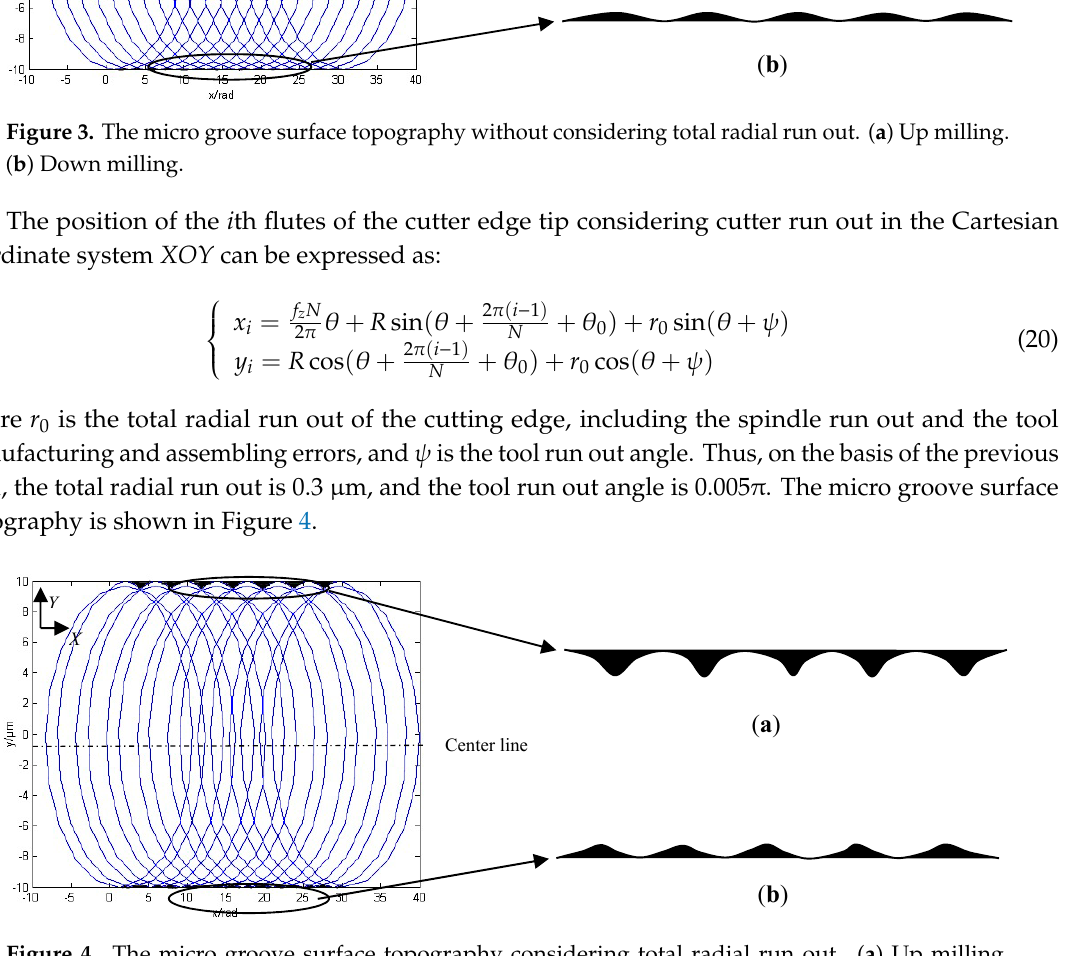
Figure 3. The micro groove surface topography without considering total radial run out. ( a ) Up milling. ( b ) Down milling.